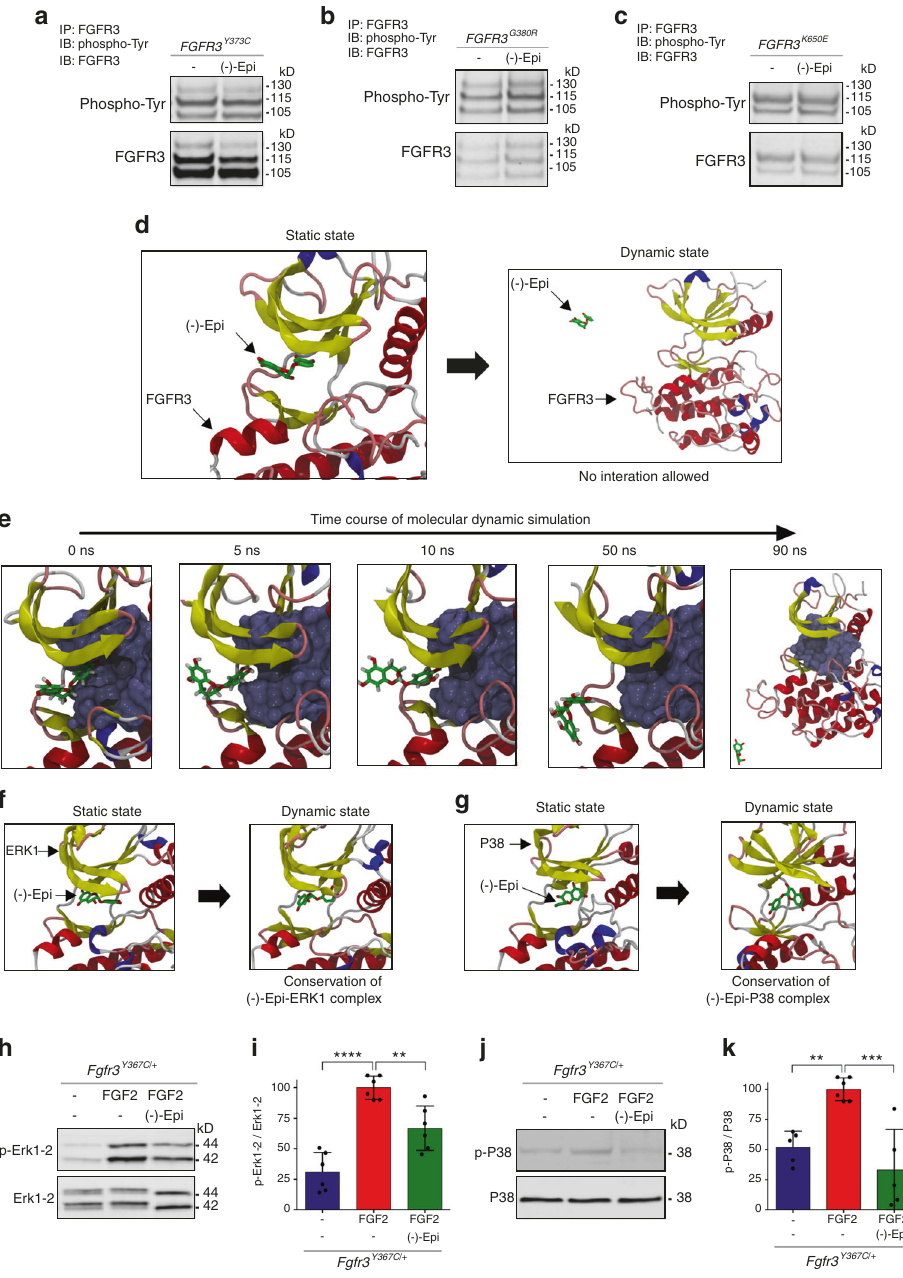
Fig. 2 (-)-Epicatechin acts downstream of FGFR3 on cartilage homeostasis. a , b , c Representative western blots of tyrosine-phosphorylated FGFR3 (p-Tyr) expression from FGFR3 immunoprecipitated from HEK293 cells transfected with FGFR3 Y373C ( a ), FGFR3 G380R ( b ), and FGFR3 K650E ( c ) exposed or not to (-)-epicatechin. d – g Computational results of (-)-epicatechin binding to FGFR3. In all these images, the protein is displayed as ribbons (yellow: β -sheet, red: α -helix, pink: turn and white: random coil), and the ATP active site is presented as a molecular surface in ice blue. (-)-Epicatechin is displayed in CPK colors with carbon in green. Structures on the top ( d , top) correspond to the FGFR3-(-)-epicatechin complex after molecular docking. The hydrogen bonds between interacting residues (presented with gray carbon atoms) are shown with dashed lines. The structure on the bottom ( d , bottom) was obtained after molecular dynamics and hyperdynamics simulations. e Detailed illustrations of the dissociation of (-)-epicatechin from FGFR3 kinase. From left to right, snapshots were extracted after 0, 5, 10, and 50 ns of classical molecular dynamics and after 40 ns of hyperdynamics (see Supplemental Movie 1). f , g Representative structures of (-)-epicatechin complexed with the kinases ERK1 ( f ), ERK2 (Supplementary Fig. 4) and p38 ( g ). The complexes obtained after molecular docking (i.e., static states) are shown on the left, and those obtained after the molecular dynamics and hyperdynamics simulations (i.e., dynamic states) are shown on the right. The ATP-binding sites are presented as molecular surfaces in ice blue. h Representative western blots of the expression levels of p-ERK1/2 and ERK1/2 in primary chondrocytes isolated from the femoral cartilage of Fgfr3 Y367C/ + mice. i Changes in the ratio of p-ERK1/2 to ERK1/2 ( n = 5). j Representative western blots of the expression levels of p-p38 and p38 in primary chondrocytes isolated from the femoral cartilage of Fgfr3 Y367C/ + mice. k Changes in the ratio of p-p38 to p38 ( n = 5). Data are presented as the mean ± SD. ns, not signi fi cant; *P < 0.05; **P < 0.01; ***P < 0.001; ****P < 0.000 1 by two-tailed, unpaired t test. The gray density analysis for the western blot data was performed by using ImageJ